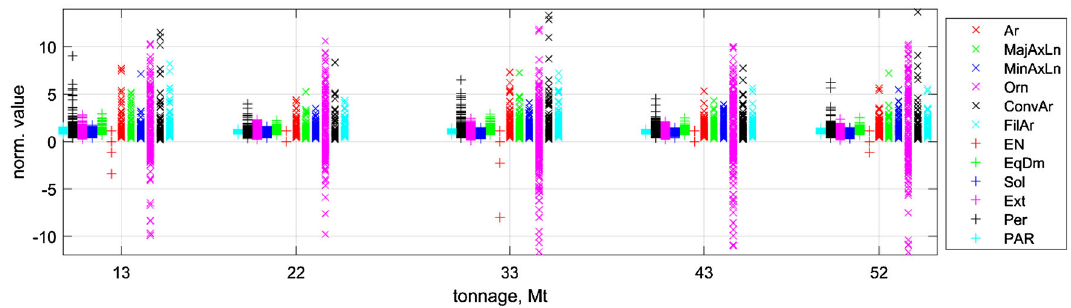
Fig. 9 Normalised feature values of image